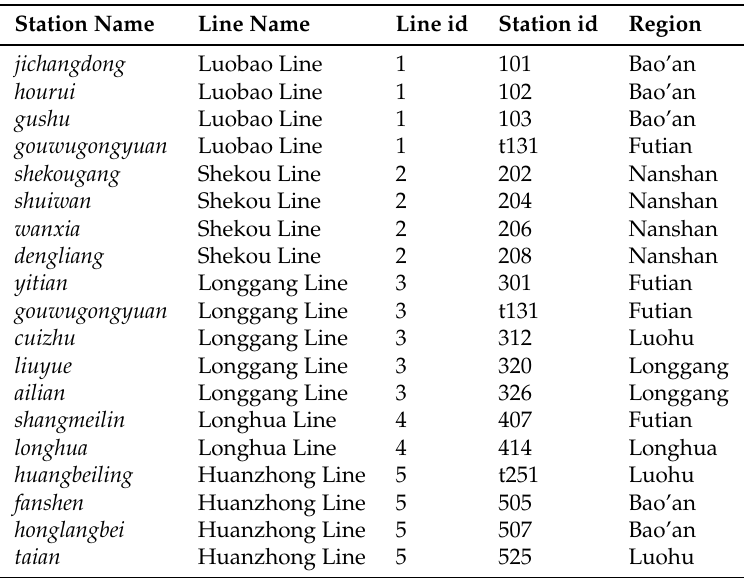
Table 4. Outlier stations of Cluster